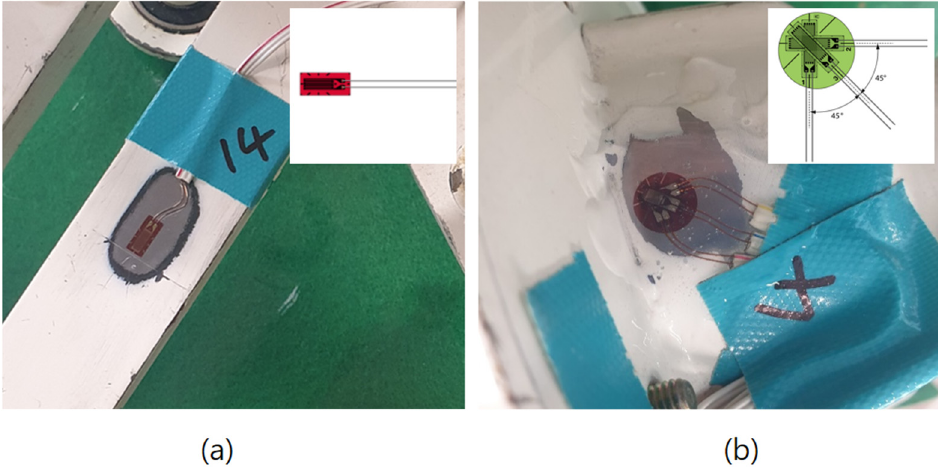
Figure 4. The type of strain gauge used in this study: ( a ) uniaxial strain gauge, ( b ) triaxial strain gauge.